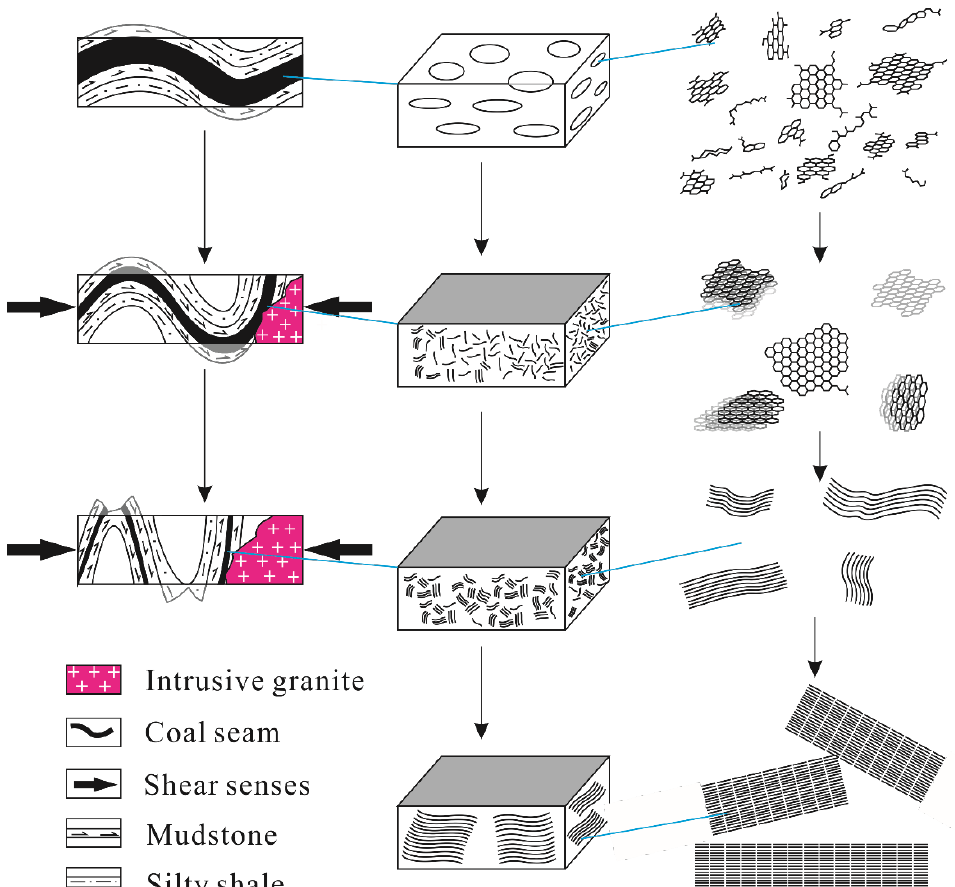
Figure 7. Strain-induced graphitization model of coal seam-derived graphite.